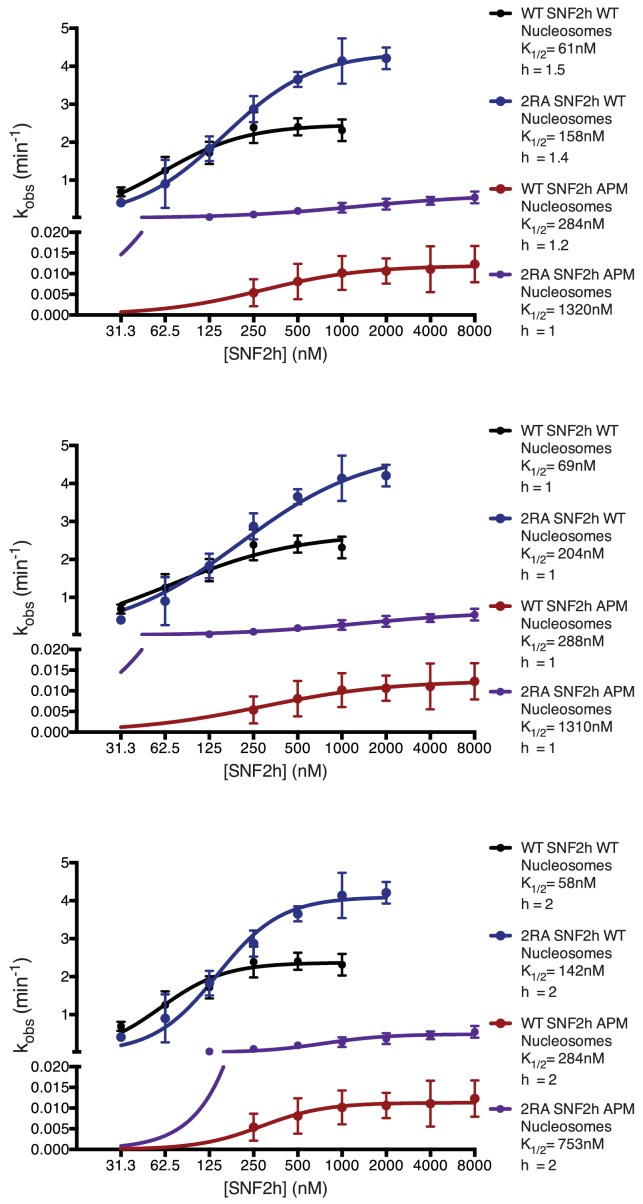
Saturation Kinetics Experiments.Fits of the dependence of remodeling rates on enzyme concentration for each enzyme-substrate pair. Previous work indicates that SNF2h cooperatively remodels nucleosomes as a dimer, suggesting the data should fit to a hill coefficient greater than 1 (Racki et al., 2009). However, we cannot rule out that mutations may affect the cooperative association of SNF2h. To address this, reactions were fit with either a floating hill coefficient (top) or constrained to hill coefficient of 1 (middle) or 2 (bottom). Both Kmapp and kmax change less than 2-fold regardless of whether the data are fit to a fixed hill coefficient or fit to a floating coefficient.10.7554/eLife.35322.016Figure 2—figure supplement 3—source data 1.Values used to obtain plots.